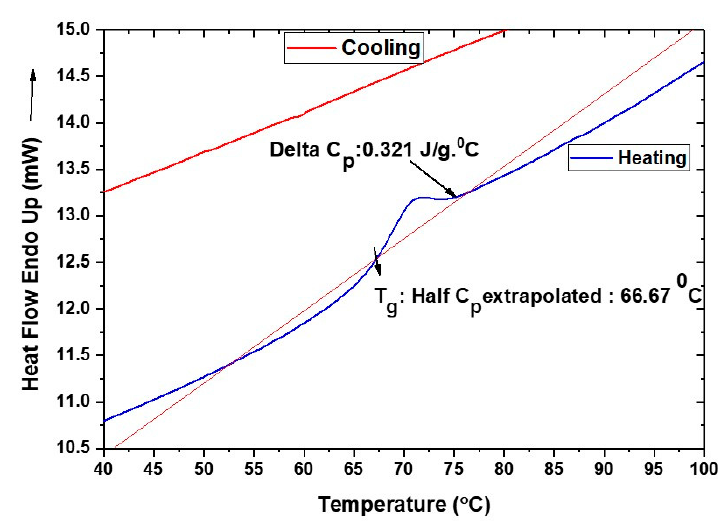
Figure 2. Differential scanning calorimetry curves: the blue color for heating poly (methyl methacrylate), and the red color one for cooling poly (methyl methacrylate).